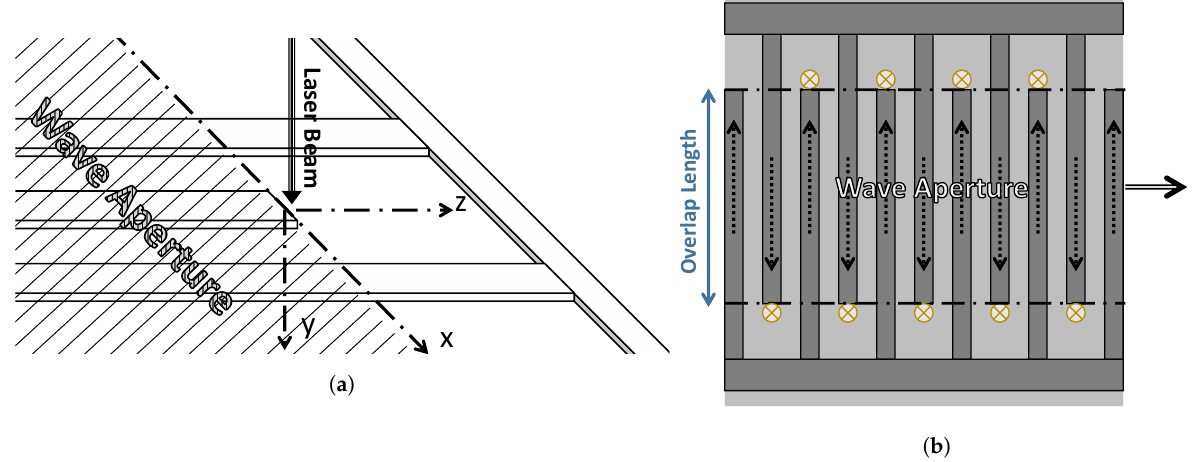
Figure 1. ( a ) The experimental configuration of the proposed measurement technique. ( b ) Positions of the laser spot (marked by × ), the displacement field u ( x , y , z , t ) (marked by the dashed-line arrows), and the propagation direction of the shear horizontal (SH) wave (marked by the double-line